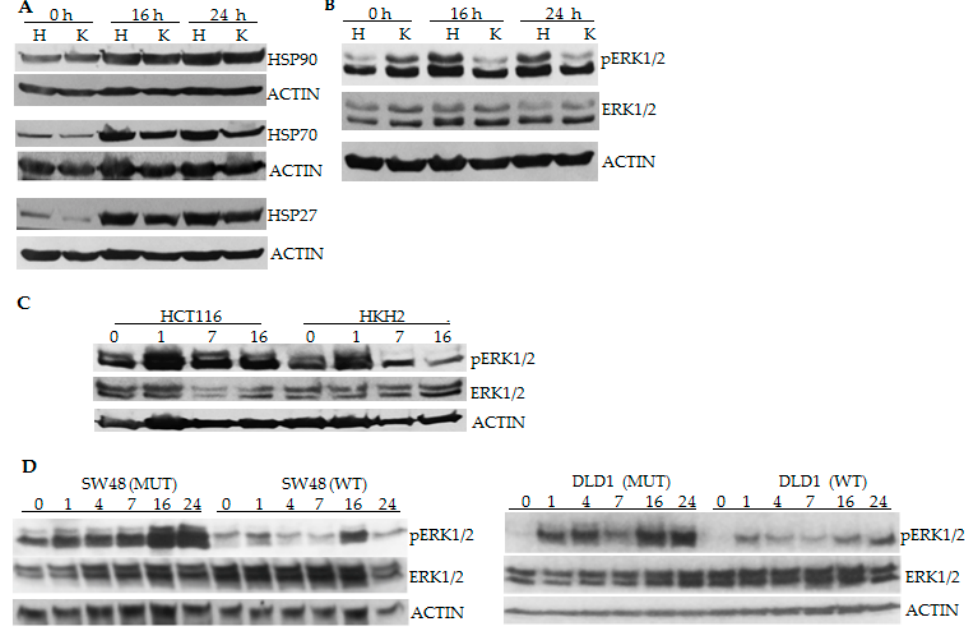
Figure 2. The induction of ERK1/2 by hyperthermia exhibits a different temporal pattern in CRC cells with a wild type and mutant KRAS . ( A – C ) HCT ‐ 116 (H) and HKH2 (K) cells were exposed to 42 °C for 0, 1, 7, 16 or 24 h. Total cell lysates were analyzed by Western blotting, and probed for heat shock proteins (HSP), total ERK1/2, phosphorylated (p) ERK1/2 and ACTIN; ( D ) SW48 and DLD ‐ 1 pairs of isogenic cell lines with a wild type (WT) or mutant (MUT) KRAS were exposed to 42 °C for 0, 1, 7, 16 or 24 h and total cell lysates were analyzed as in (A).